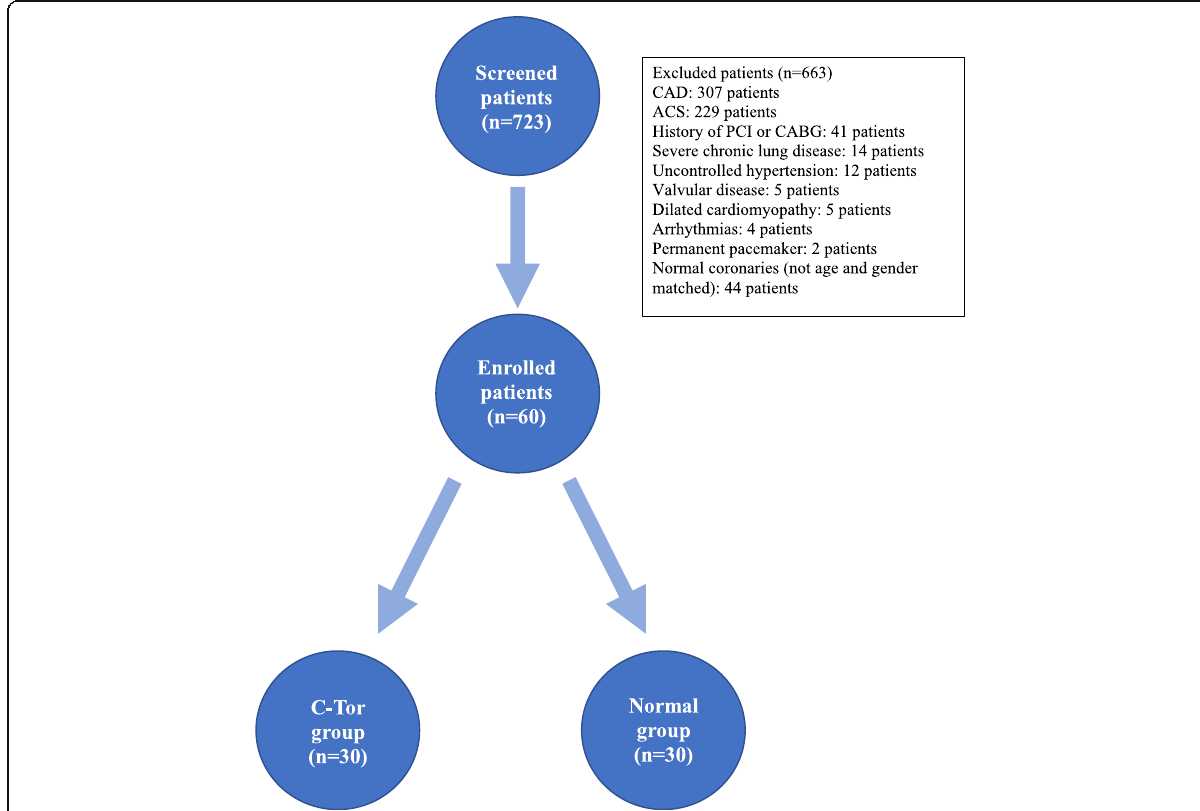
Fig. 5 Flow chart of the patients in the study. CAD coronary artery disease, PCI percutaneous coronary interventions, CAG coronary artery bypass grafting, C - Tor coronary tortuosity